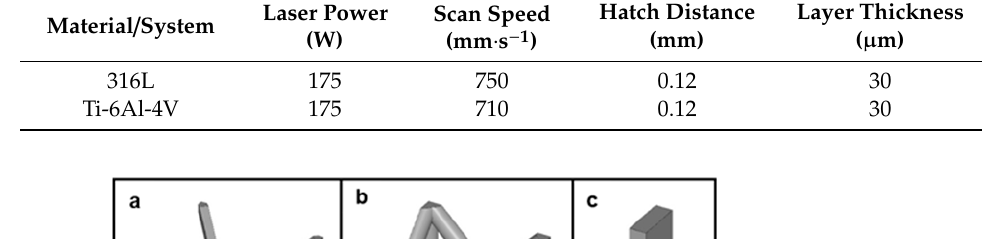
Table 2. Process parameters employed for manufacturing of the cylindrical test specimens and the bulk grip section of lattice test specimens.